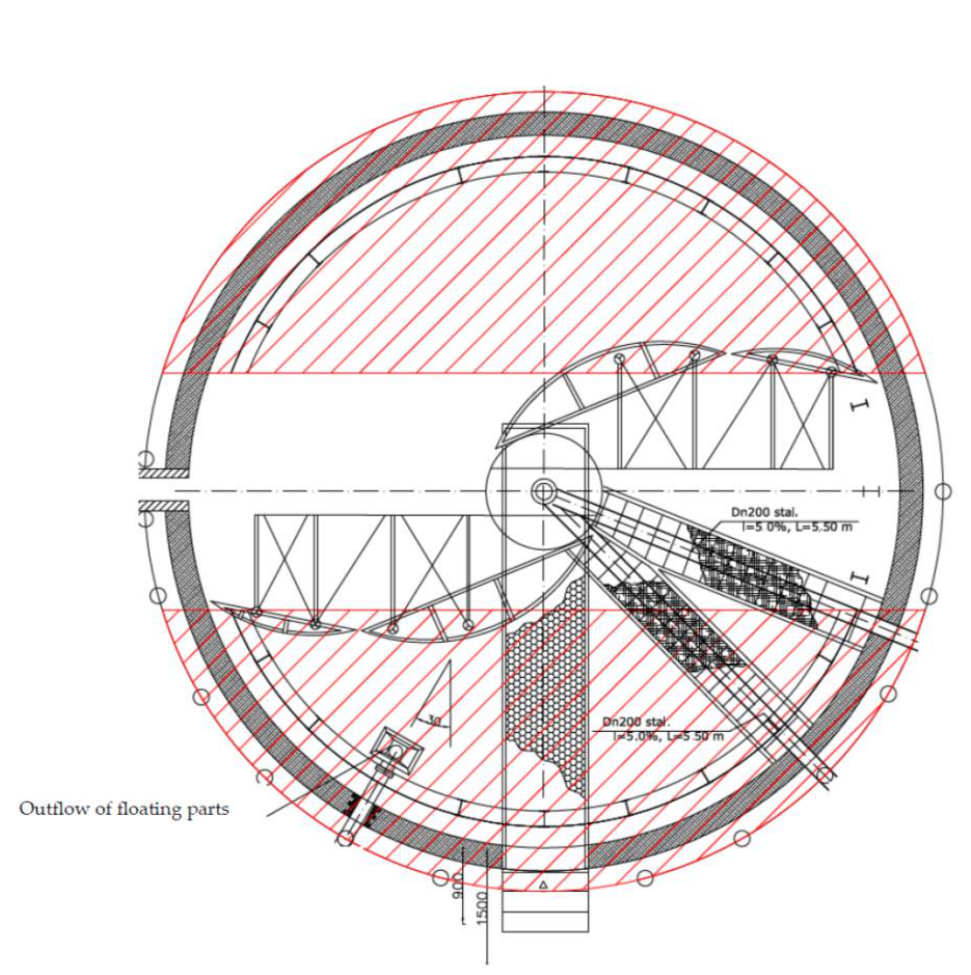
Figure 1. Scheme of adaptation of the existing secondary settling tank to the MBR chamber. Source: Architectural and construction project of the wastewater treatment plant (WWTP) in Wydminy by BACT-sp. Z o.o. [26].